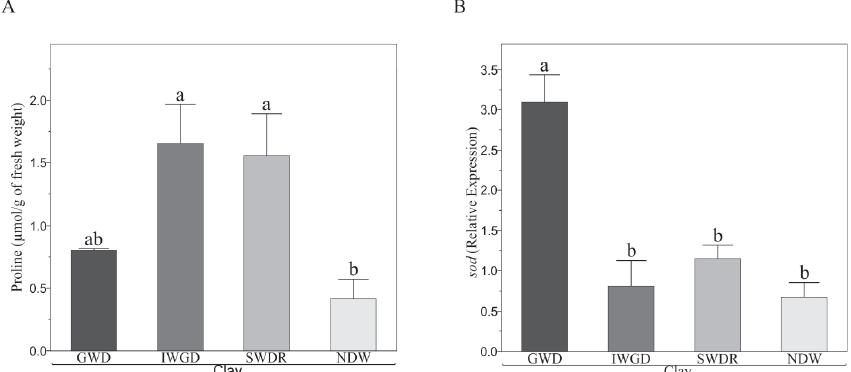
Figure 8. Proline accumulation and SOD gene expression in chili pepper plants grown in clay soil with different irrigation regimes. Results of the comparison of means ± S.E. by using Tukey ′ s test of the biochemical variables. ( A ) Proline; ( B ), Superoxide dismutase ( SOD ). In all cases, p = 0.05. Gradual water deficit (GWD), initial waterlogging with gradual water deficit (IWGD), sudden water deficit with gradual recovery (SWDR), no deficit of water (NDW).